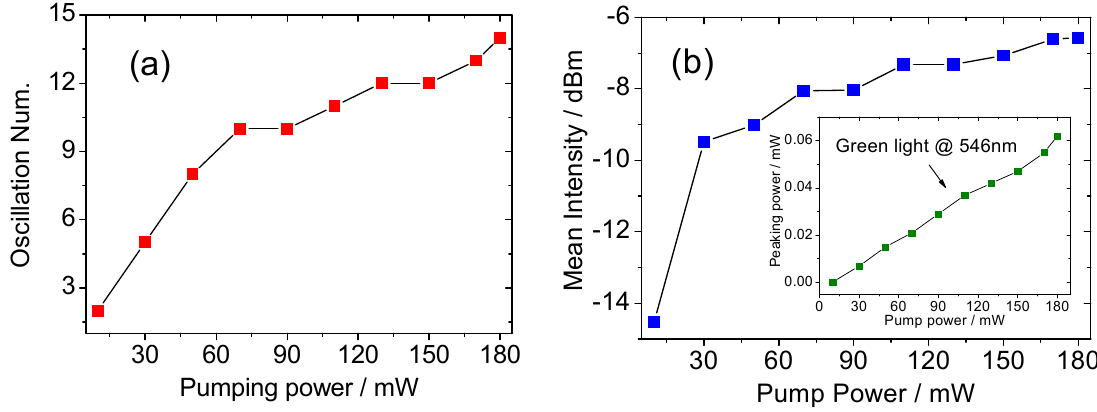
Figure 5. The outputs with varying pumping power when R 1 = 50/50, ( a ) oscillation number within 3-dB bandwidth; ( b ) mean intensity of oscillations (where the subfigure is stimulated green light with central wavelength of 546 nm).